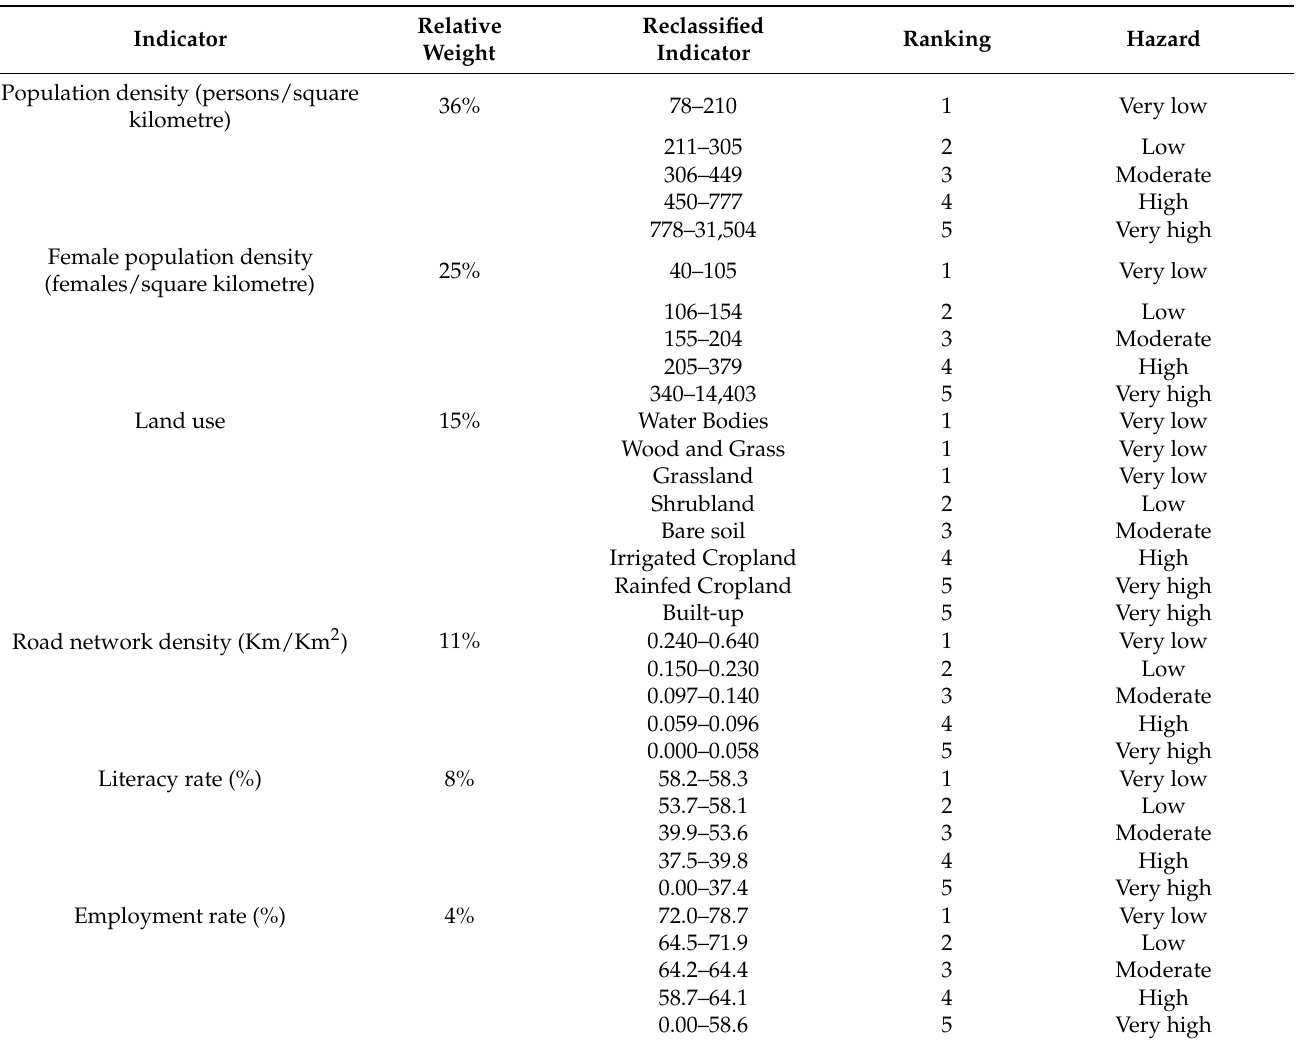
Table 6. Classes of flood vulnerability indicators, and their weight and